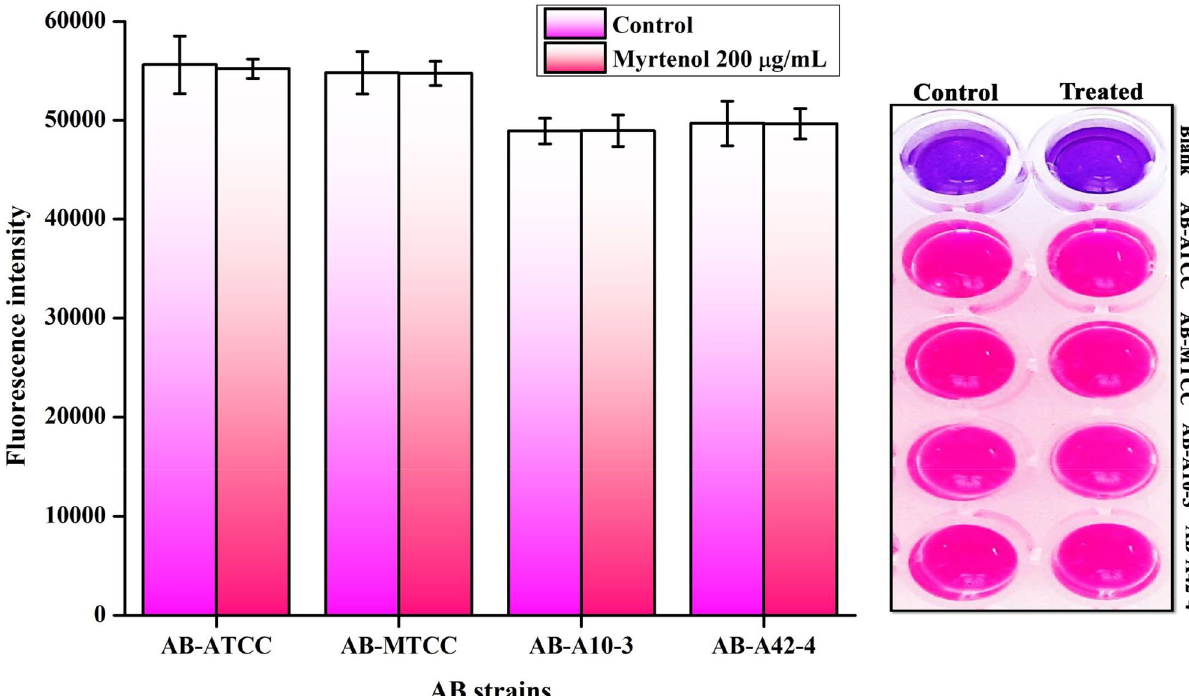
Figure 4. Effect of myrtenol (200 μg/mL) on viability of AB-ATCC 19606, AB-MTCC 9826, AB-A10-3 and AB-A42-4 as assessed by Alamar blue reduction assay. Error bars indicate the SD.